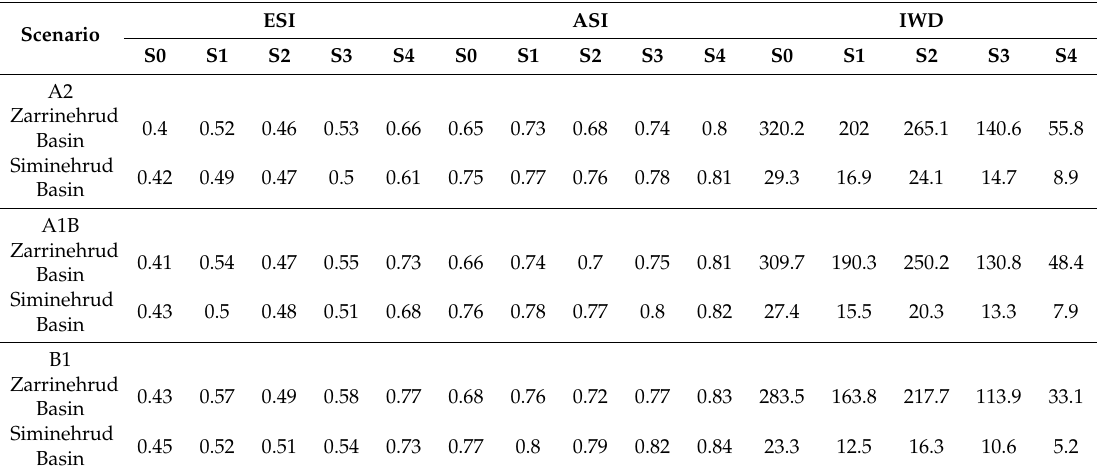
Table 7. Evaluation of ESI 1 , ASI 2 and IWD 3 for Zarrinehrud and Siminehrud River basins.